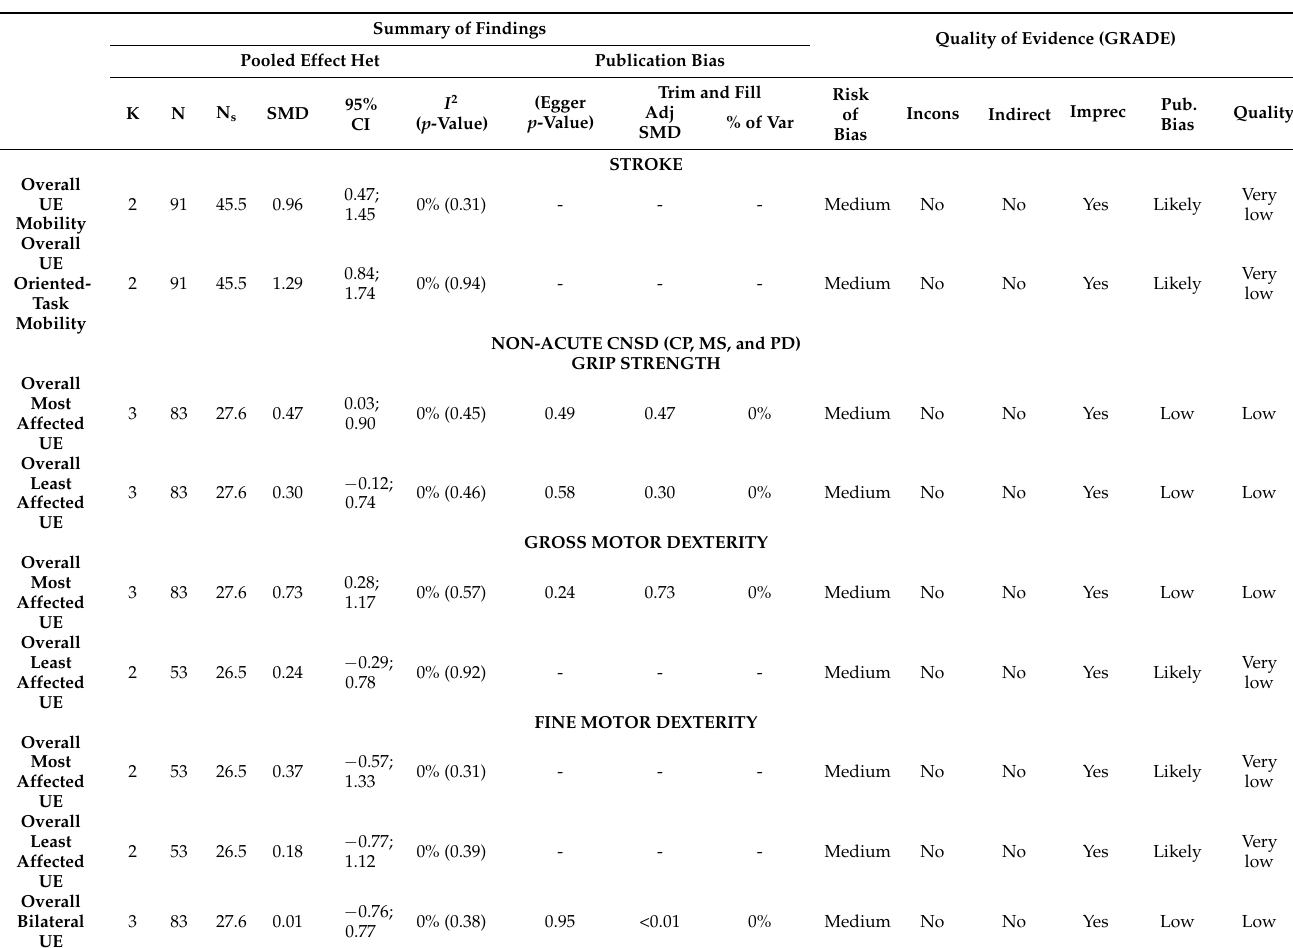
Table 4. Main findings of each